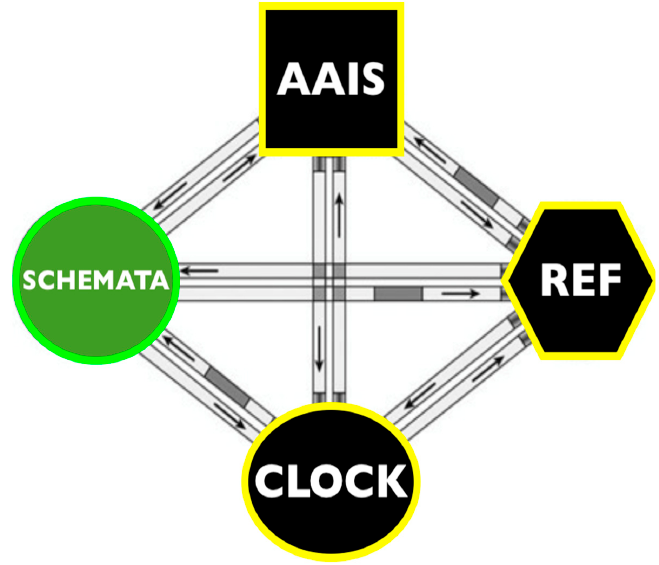
Figure 8. The reset equilibrium function (REF), clock, and approach-avoidance-inhibition system (AAIS) interconnect with action schemata to regulate voluntary action.